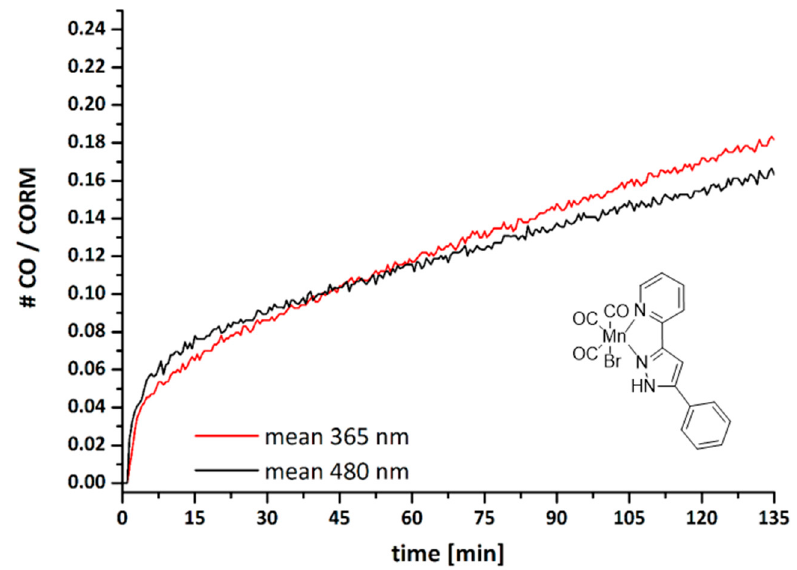
Figure 5. Carbon monoxide release kinetics upon illumination of crystalline [(OC) 3 Mn(Br)(2-PyPz Ph )] ( 2a ) at 365 nm ( red ) and at 480 nm ( black ).